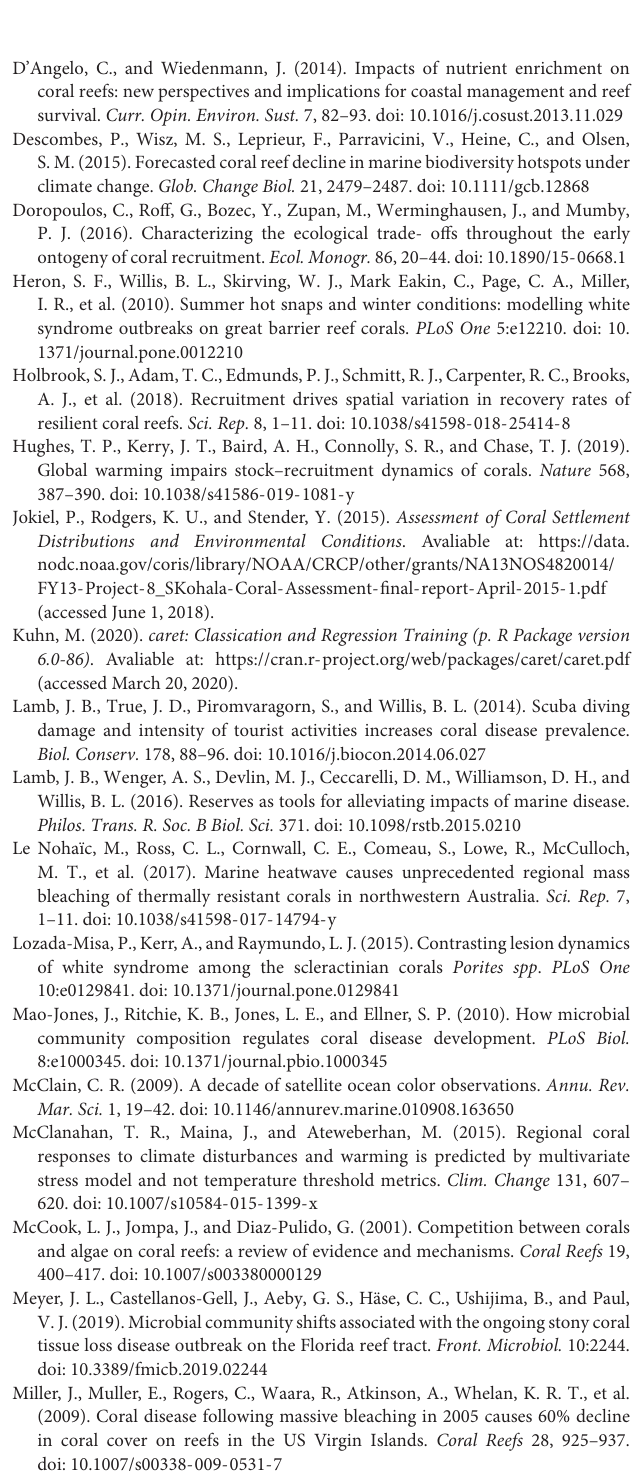
Solid lines represent predicted White Syndrome probability on training data, dashed lines represent predictions for reserved data. Supplementary Table 1 | Table of species codes used in survey data and corresponding scientific names. Species appearing in the consensus dataset have had their code and scientific name